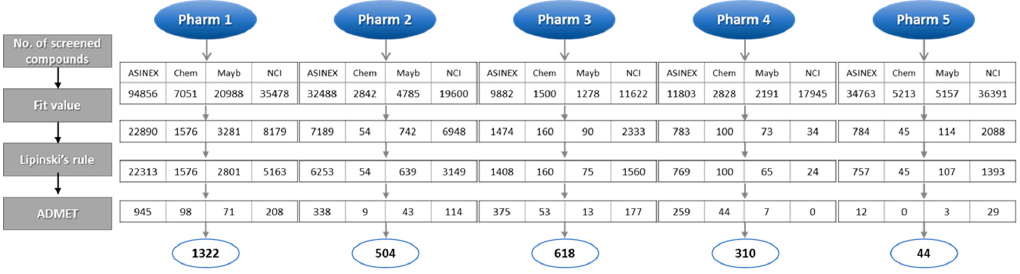
Figure 5. Database screening using pharmacophore models (Pharm 1–5). The number of hit compounds in each filtration process was shown along with the database name.